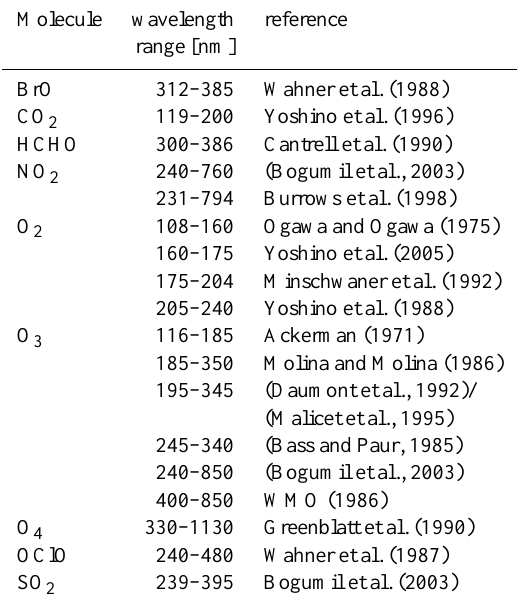
Table 3. Absorption cross section data included in libRadtran; the non-default parameterizations are put in